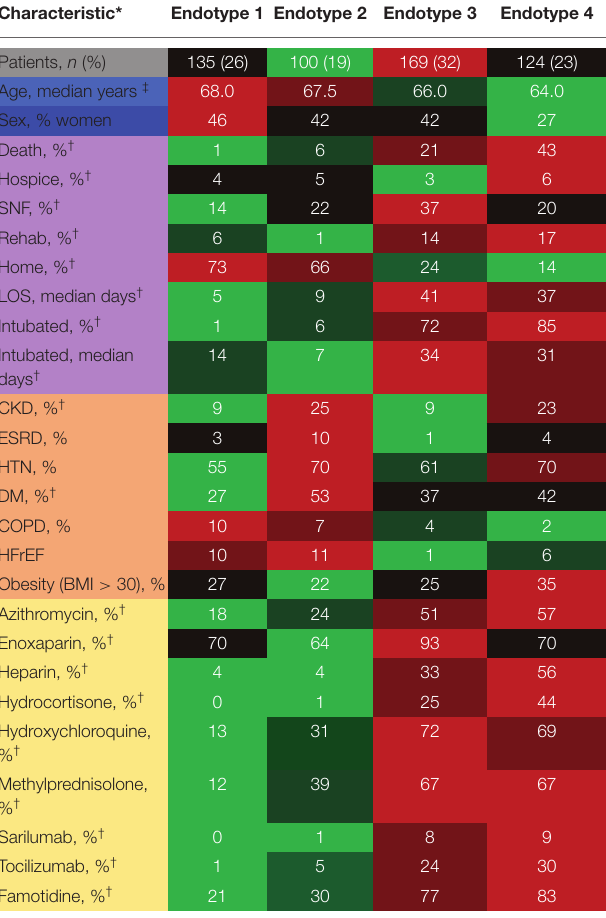
TABLE 2 | Selected endotype features. Feature*